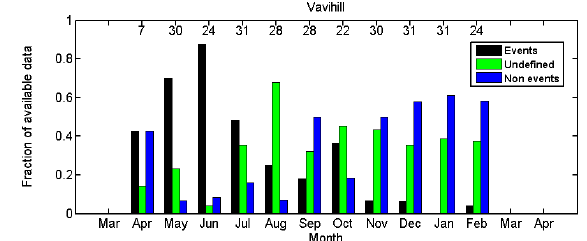
Fig. A3. The fraction of event, undefined and non-event days out of all analyzed days during each month in the year at Vavihill, Sweden, during April 2008–February 2009.